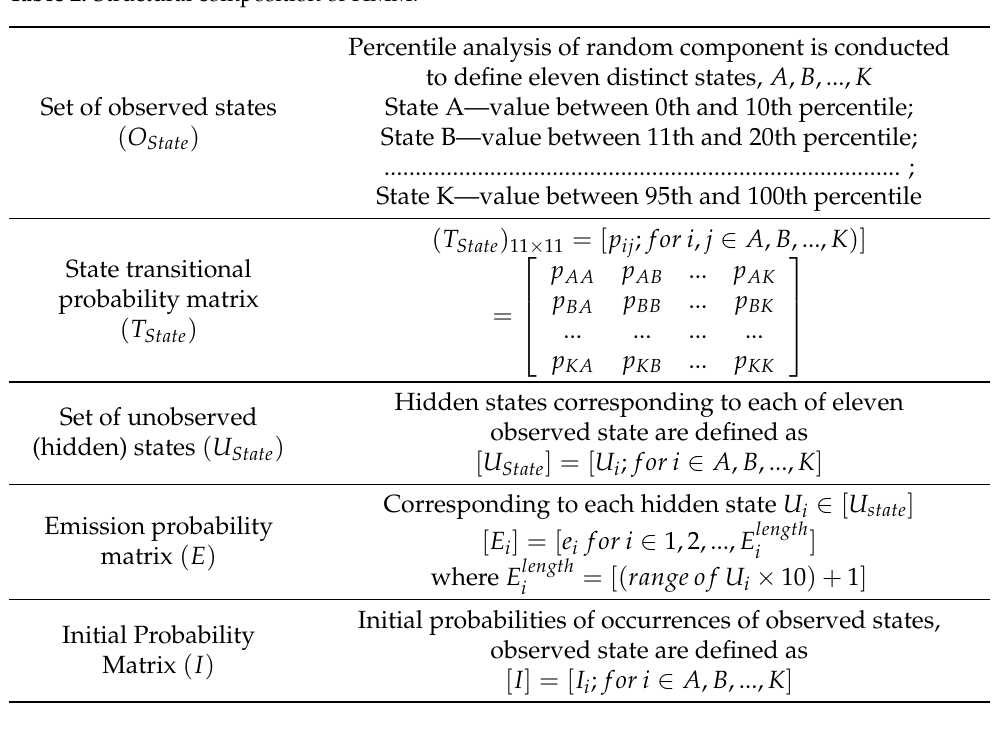
Table 2. Structural composition of HMM.